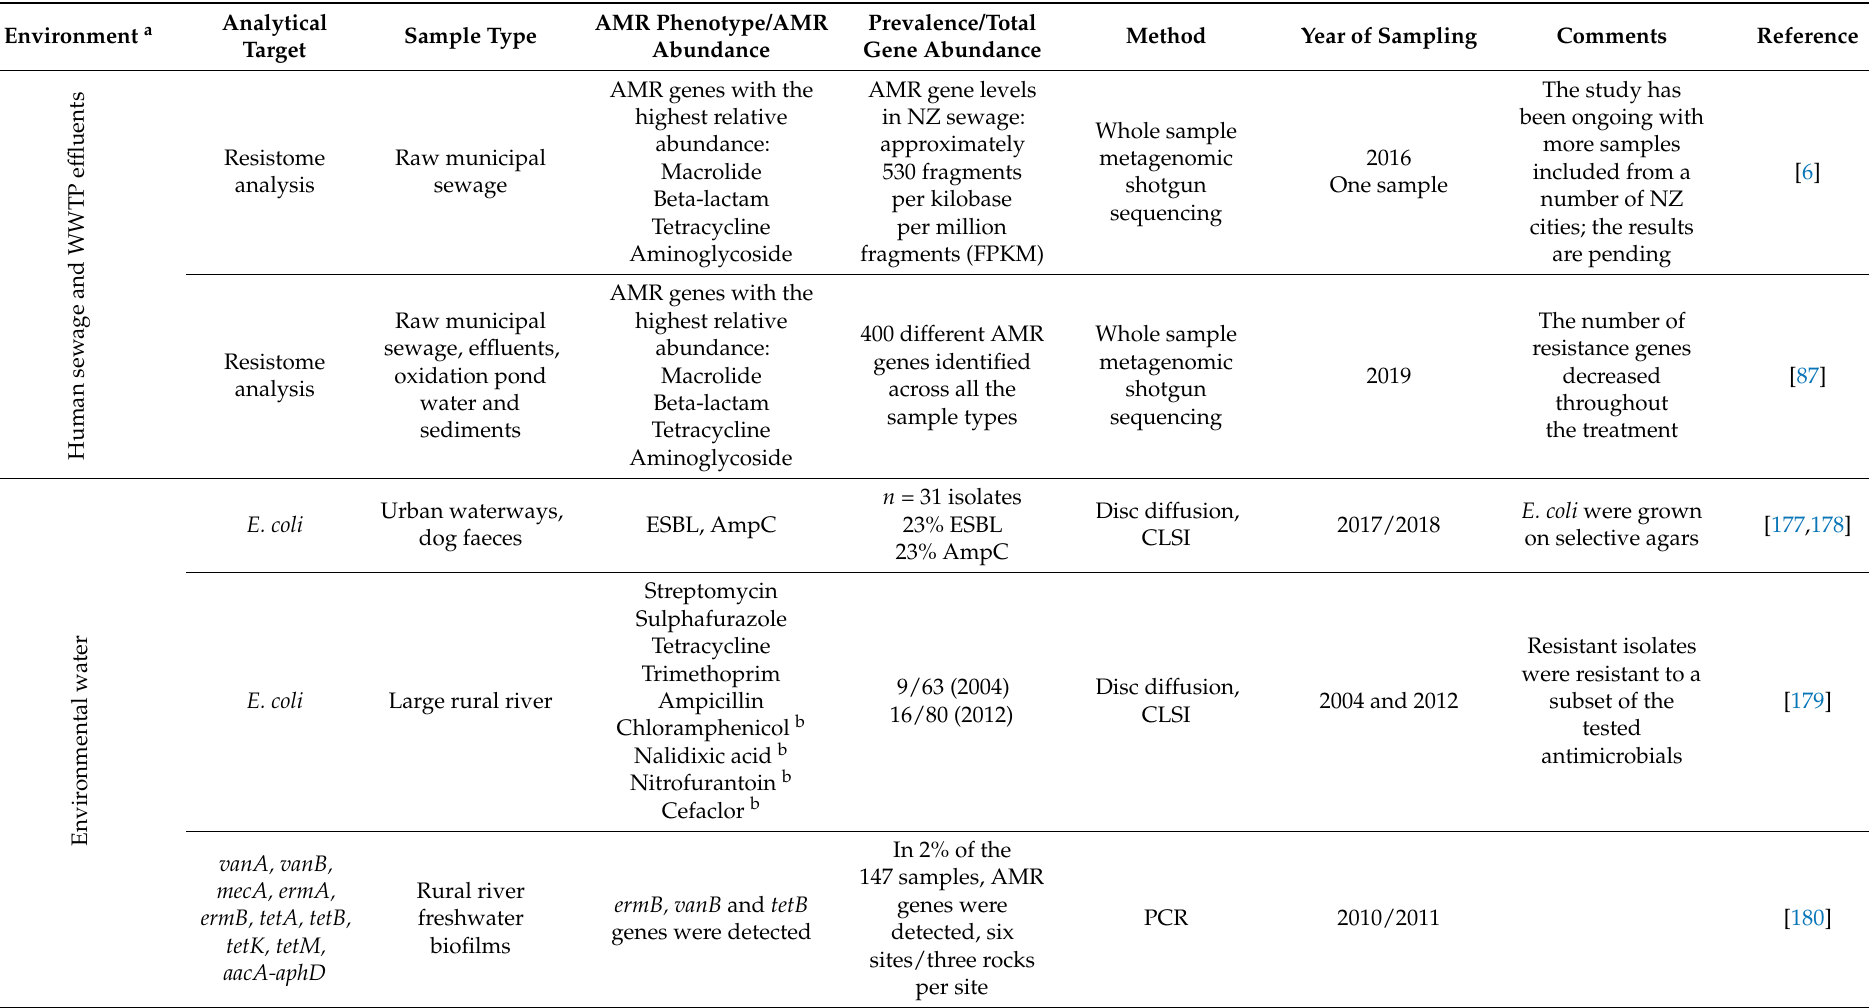
Table 2. Antimicrobial resistance in the New Zealand